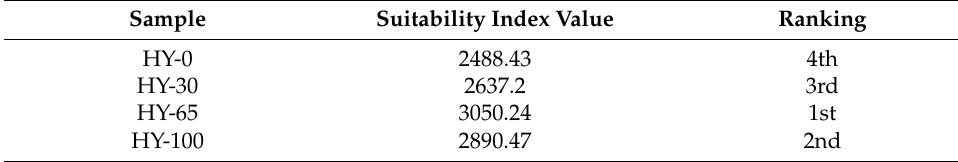
Figure 5 represents the decision of matrices with the help of different colors. Further- ance to it, the normalized values of all hybrids are shown in Table 4. Table 4. Suitability index value (SIV) and ranking of